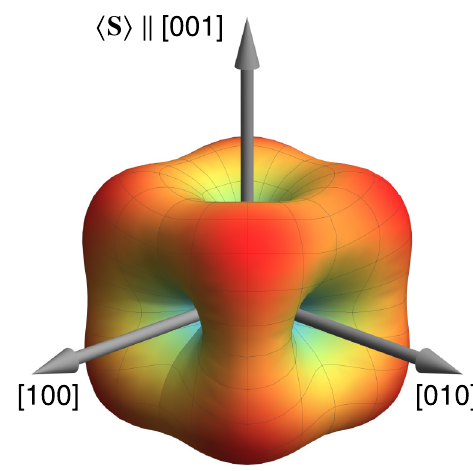
FIG. 16. Magnitude of the electric ground-state polarization p ( 0 ) and the bilinear p ( 2 ) as a function of the ground-state spin polarization (cid:7) S (cid:8) in the collinear phase of Cu 2 OSeO 3 . For (cid:7) S (cid:8) along the a , b , or c direction, which respectively corresponds to [100], [010], or [001], there is zero p ( 0 ) and p ( 2 ) . Maximal p ( 0 ) and p ( 2 ) are found for (cid:7) S (cid:8) along the (cid:7) 111 (cid:8) direction.